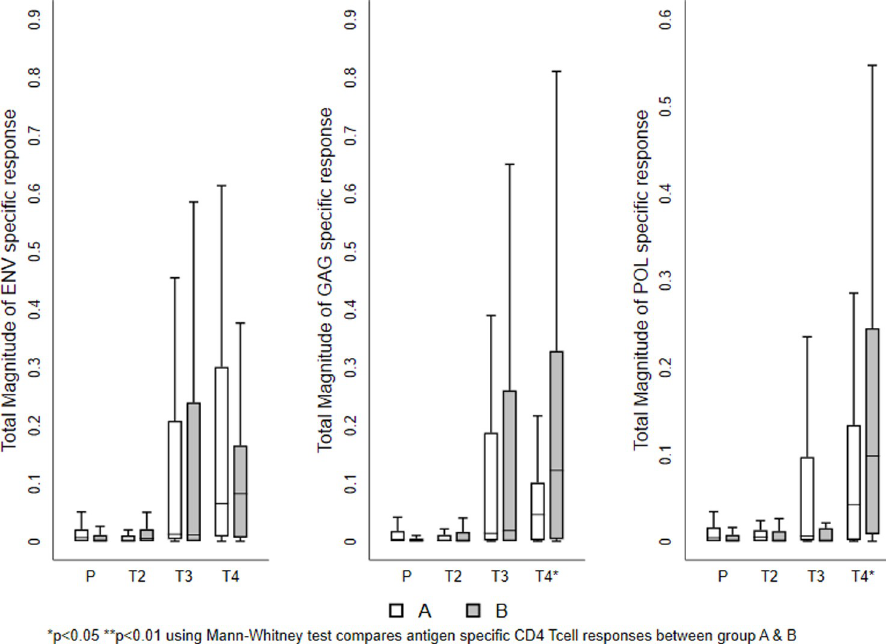
Fig 5. Vaccine-induced antigen-specific CD4 + T cell response. The mean values of the total responses (Env, Gag and Pol) are shown. A) Frequency of Env-specific CD4 + T cells (B) Frequency of Gag-specific CD4 + T cells. (C) Frequency of Pol-specific CD4 + T cells. The box plots show the distribution of responses in positive responders only. The boxes indicate the median (solid line), mean (dashed line), and interquartile range (IQR). P values were determined using Mann-Whitney T test. (Note: P-Placebo, T2-Prevaccination, T3-Second week after first MVA vaccination, T4-Second week after last MVA vaccination).